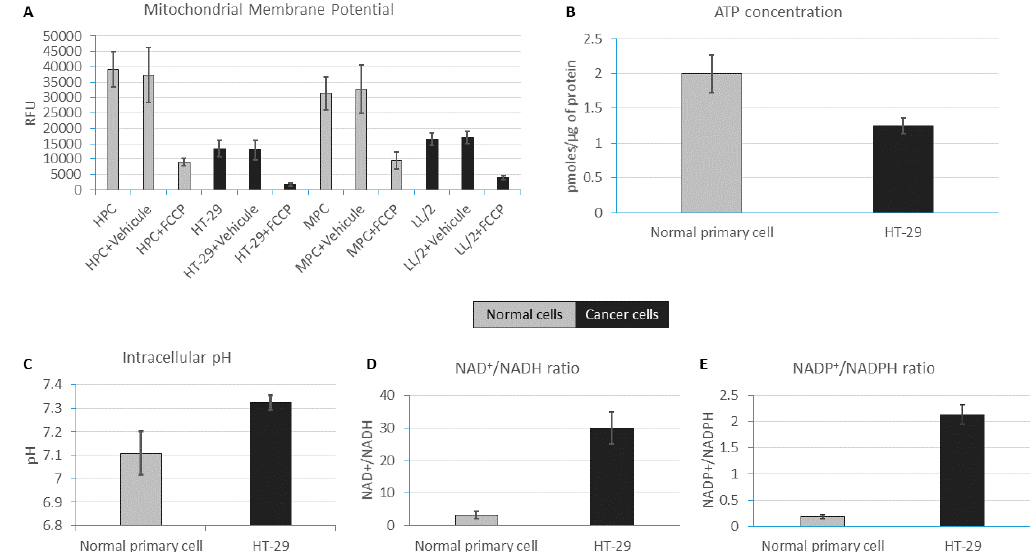
Figure A2. MMP, ATP, pHi and redox species concentrations in normal and cancer cell lines. ( A ) MMP are measured in human and mouse normal and cancer cell lines. FCCP is a compound that carries protons across the IMM and dissipates the electrochemical gradient (membrane potential). In order to maintain the membrane potential, the mitochondria need to increase the flow of electrons and thus oxygen consumption. Optimizing the concentration of the uncoupler (FCCP) reveals the maximal respiration for the sample; ( B ) The ATP concentration is lower in HT-29 compared to normal primary cells; ( C ) The intracellular pH (pHi) is alkaline in HT-29; ( D ) The NAD + /NADH ratio is higher in HT-29 cancerous line compared to normal primary cells; ( E ) The NADP + /NADPH ratio is higher in HT-29 cancerous line. Abbreviations: MMP (mitochondrial membrane potential); FCCP (carbonyl cyanide-p-trifluoromethoxyphenylhydrazone); IMM (internal mitochondrial membrane); HPC (Hematopoietic progenitor cells), LL/2 (mouse Lewis lung cancer cell line); MPC (mouse normal pheochromocytoma cell